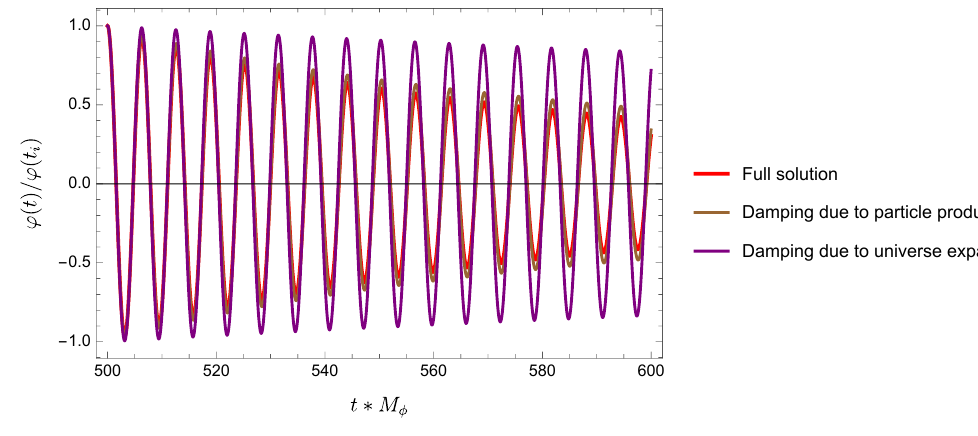
Figure 17 . Same as figure 16 but now with initial time t i M φ = 500 .